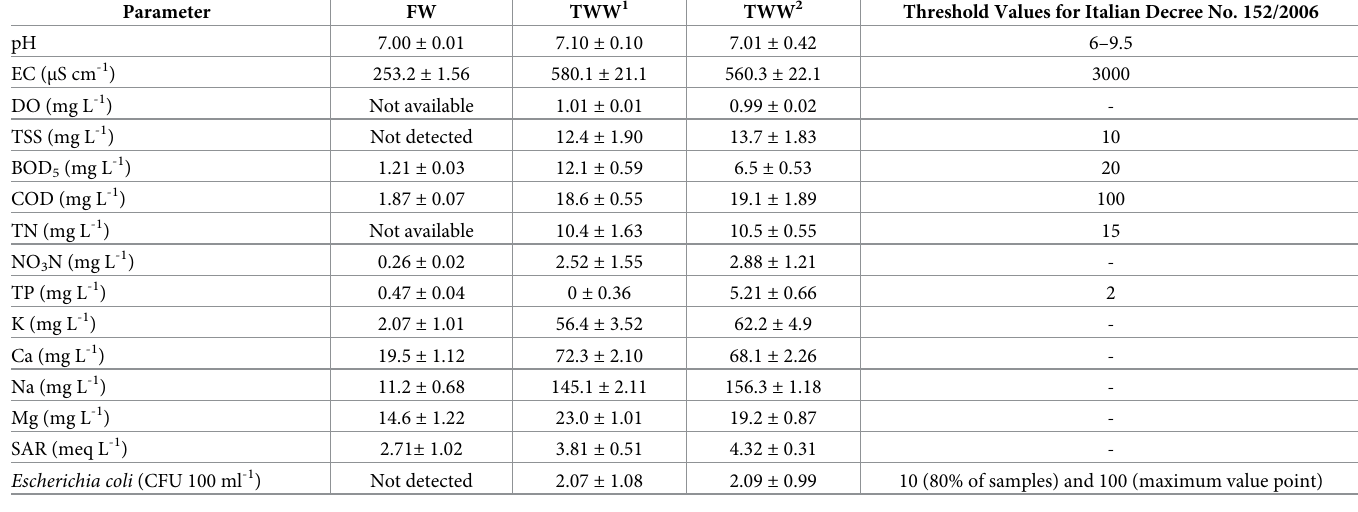
Table 5. Main chemical and microbiological characteristics of freshwater (FW) and treated wastewater (TWW) that were used for irrigation. Average values ( ± stan- dard deviation) are shown (n = 20).